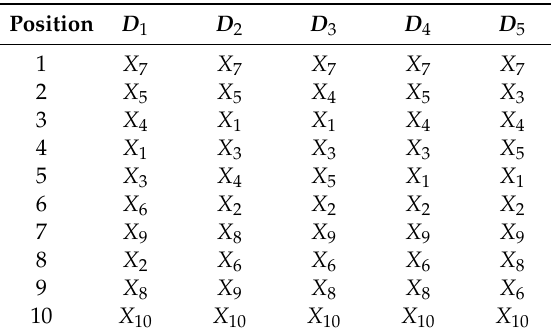
Table 8. APPs rankings of 5 exports.